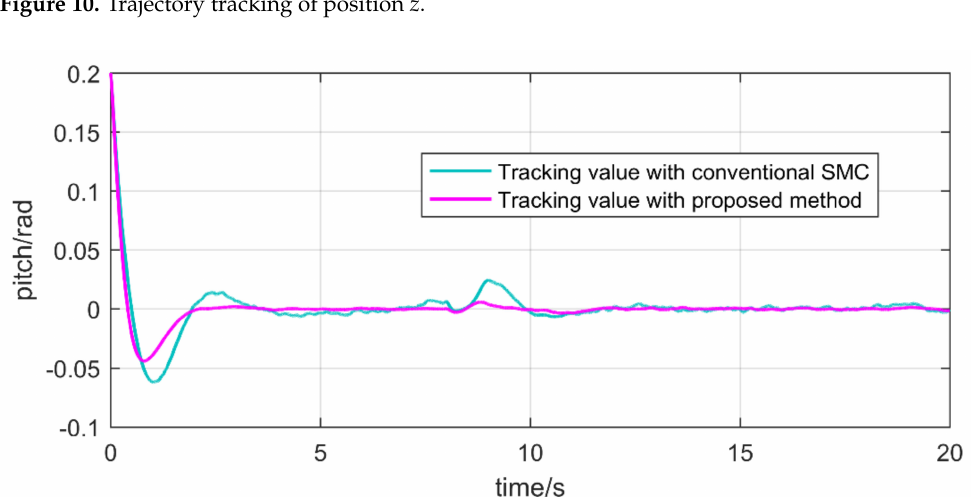
Figure 11. The tracking value of